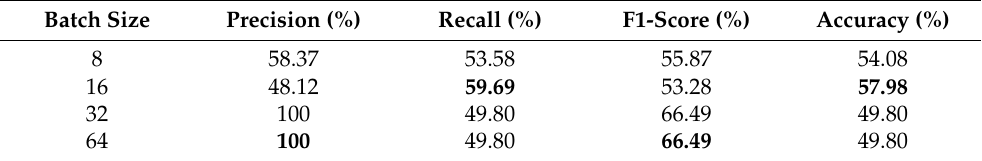
Table 4. Model’s performance for various batch sizes with ADAM optimizer and modified